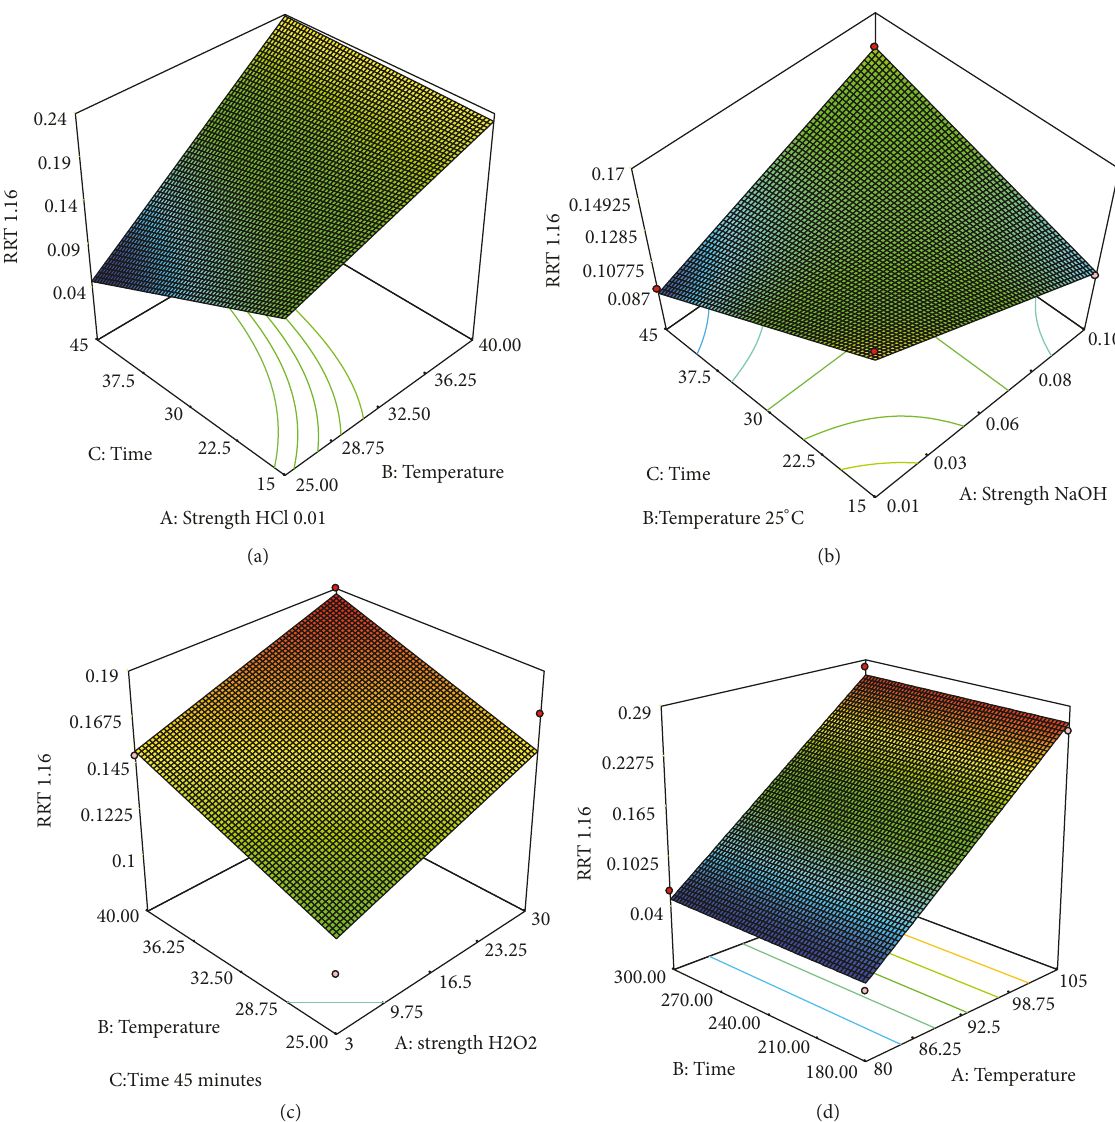
Figure 5: 3D response surface plots showing the formation of impurity RRT 1.16 under various conditions: (a) acid degradation; (b) alkali degradation; (c) oxidative degradation; and (d) thermal degradation. Color change from blue to red represents increasing degradation (min